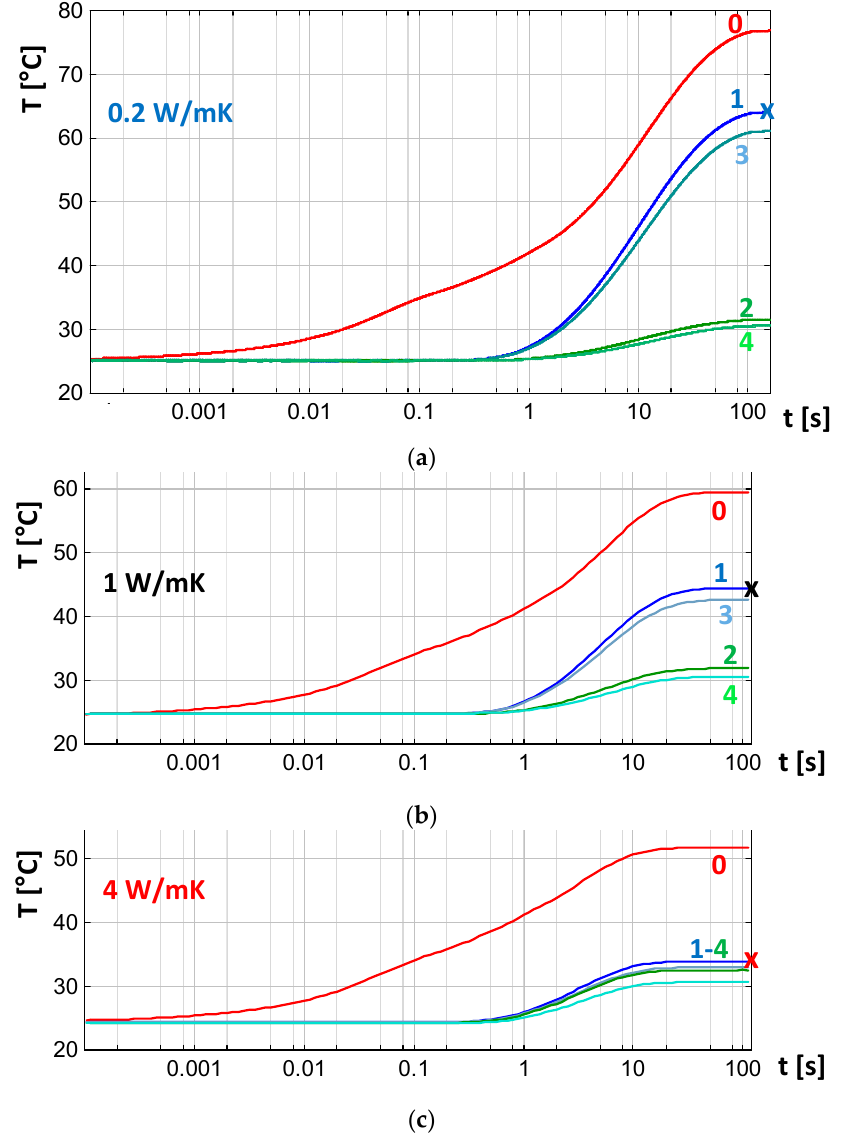
Figure 4. Simulated temperature change at 50 W, thermal conductivity of the TIM: ( a ) 0.2 W/mK, ( b ) 1 W/mK, ( c ) 4 W/mK. Ch0: junction, Ch1: case center, Ch2: cold plate top position. Ch3 and Ch4 represent small lateral displacement of the probe.